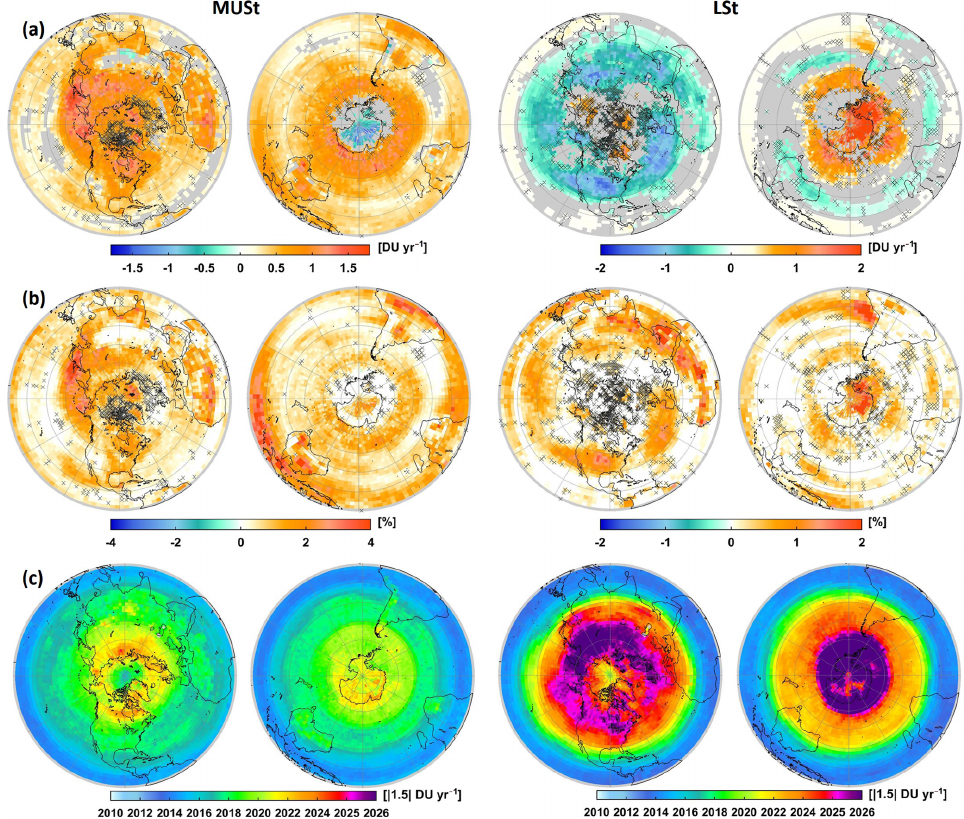
Figure 8. Global distribution (a) of the estimated annual trends (in DUyr − 1 ; grey areas and crosses refer to non-significant grid cells within the 95% confidence limit), (b) of the IASI sensitivity to trends calculated as the differences between the RMSE of the annual MLR fits with and without a linear trend term [(RMSE _w / o_LT − RMSE _with_LT ) / RMSE _with_LT × 100] (in percentage), (c) of the estimated year for a significant detection (with a probability of 90%) of a given trend of | 1 . 5 | DUyr − 1 starting in January 2008 in MUSt and LSt O 3 columns (left and right panels, respectively). Note that the scales are different for the two